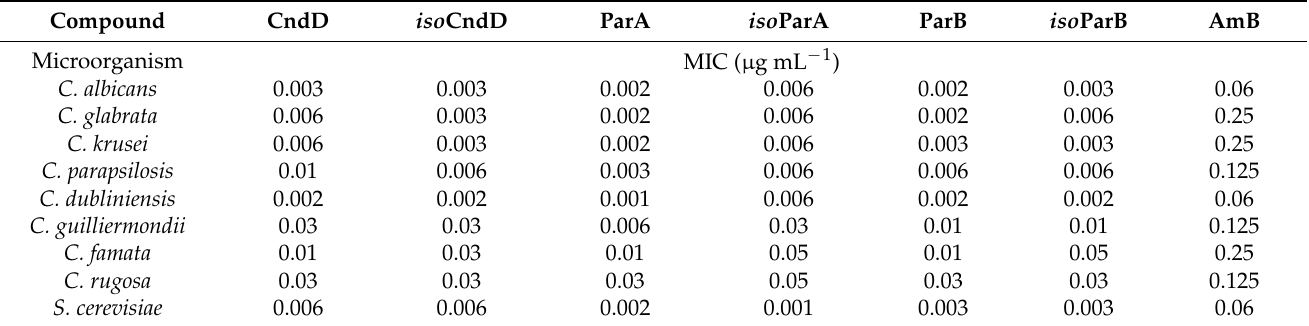
Table 2. Antifungal in vitro activity of Candicidin D (CndD), Partricin A (ParA), Partricin B (ParB), their all-trans isomers iso CndD, iso ParA, iso ParB and Amphotericin B (AmB). MIC (minimal inhibitory concentration) values were determined in BDS medium by the serial two-fold dilution method, using the 96-well microtiter plates.